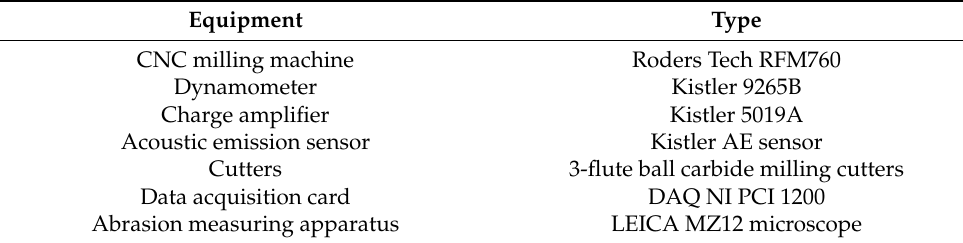
Table 1. Main equipment of the experimental